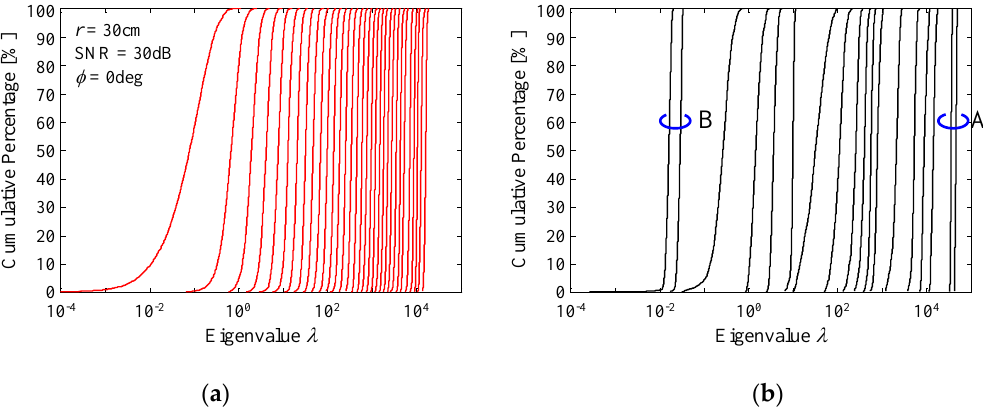
Figure 17. CDF characteristics of eigenvalues. ( a ) σ = 60°. ( b ) σ = 10°.